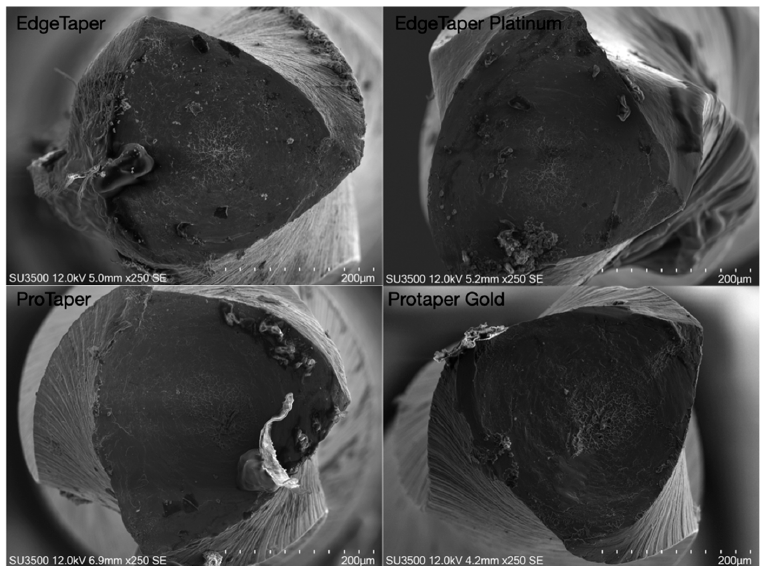
Figure 3. SEM analysis. Torsional fracture evidenced by the round shaped circumferential lines.